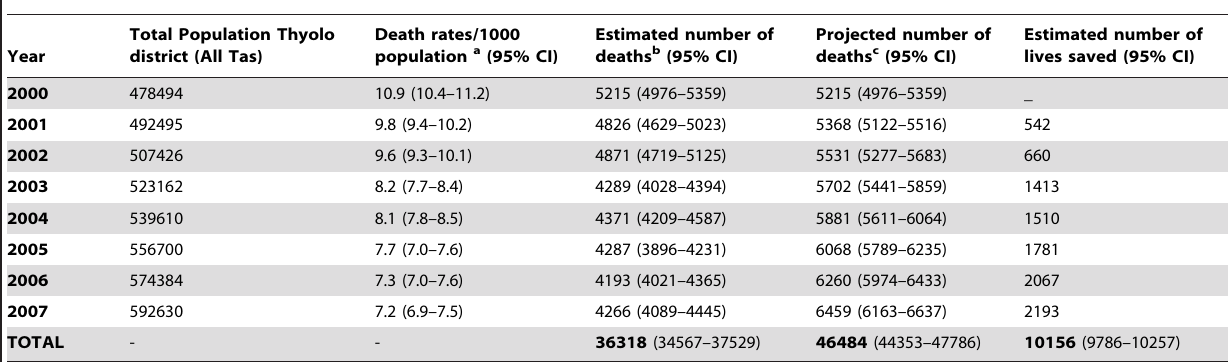
Table 2. Death rates from 5 traditional authorities projected to estimate averted deaths in the entire Thyolo district, Malawi.